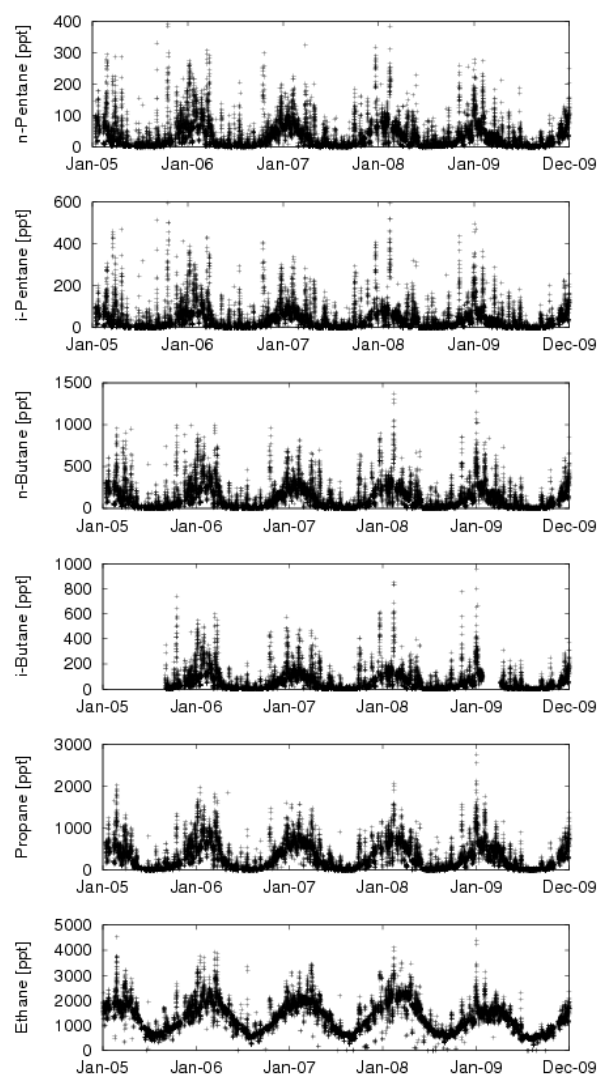
Fig. 2. All data for C 2 –C 5 alkanes from January 2005 until Decem- ber Figure 2: All data for C 2 -C 5 alkanes from January 2005 until December 2009. 2